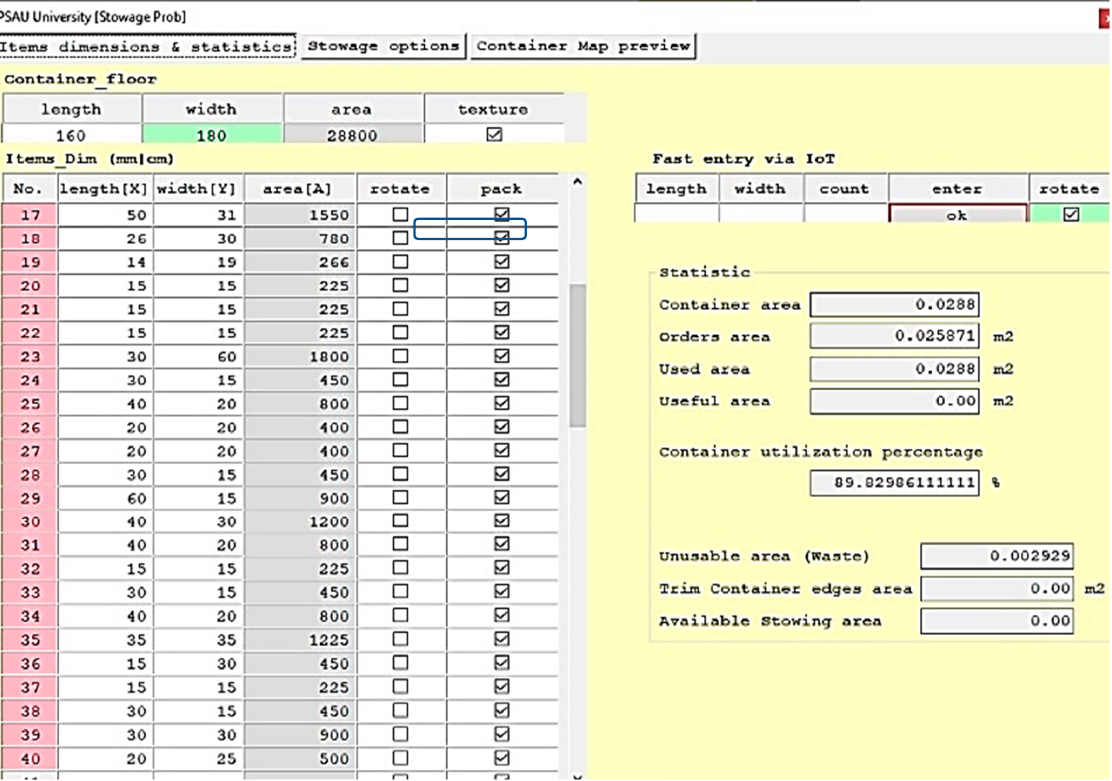
Figure A8. The container utilization by OSM-CA for third station on the distribution path.